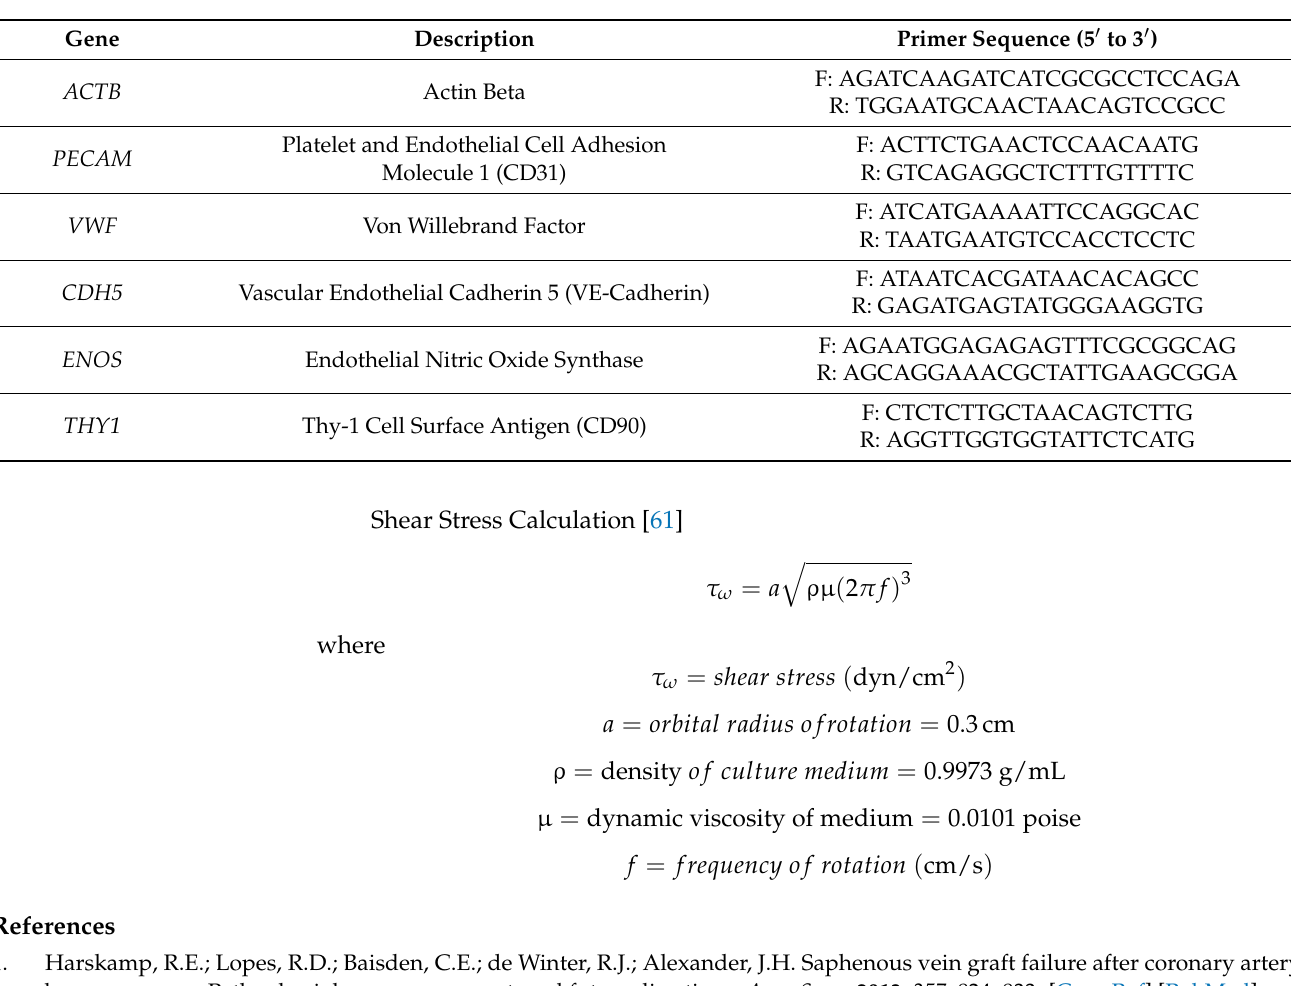
Table A4. Primer Sequences used for